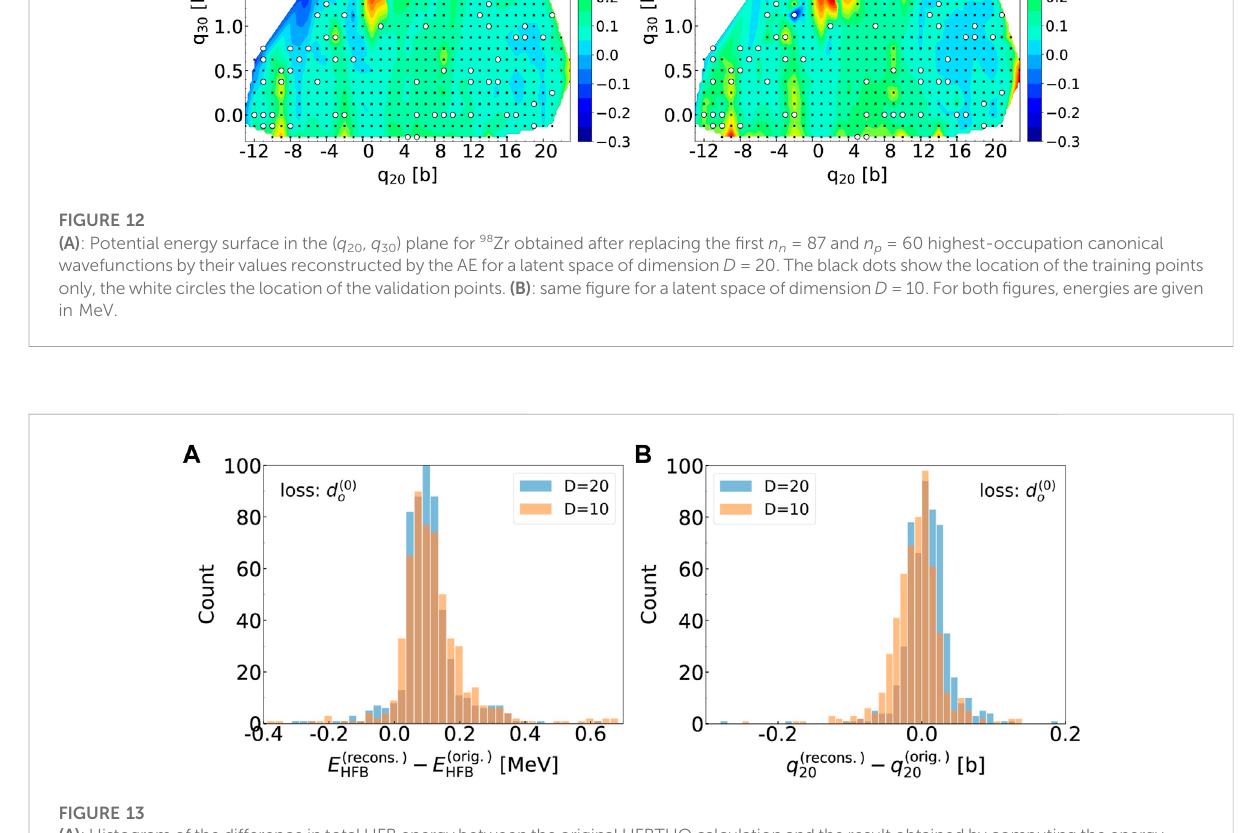
Figure 12 shows the error on the potential energy across the ( q 20 , q 30 ) collective space obtained with the reconstructed canonical wavefunctions for latent spaces of dimension D = 20 (left) and D = 10 (right). In each case, we only show results obtained when using the d ( 0 ) loss, which gives the best o results. The black crosses denote the location of all the original points; the white circles show the location of the validation points. Overall, the results are very encouraging. In both cases, most of the error is concentrated near regions of the